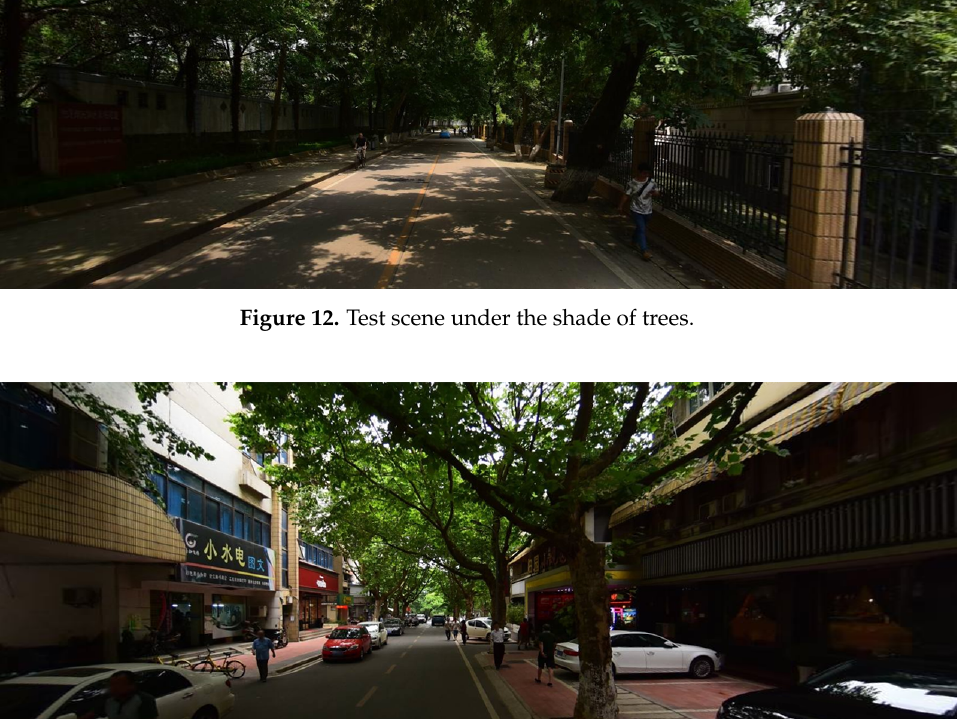
Figure 13. Test scene beside